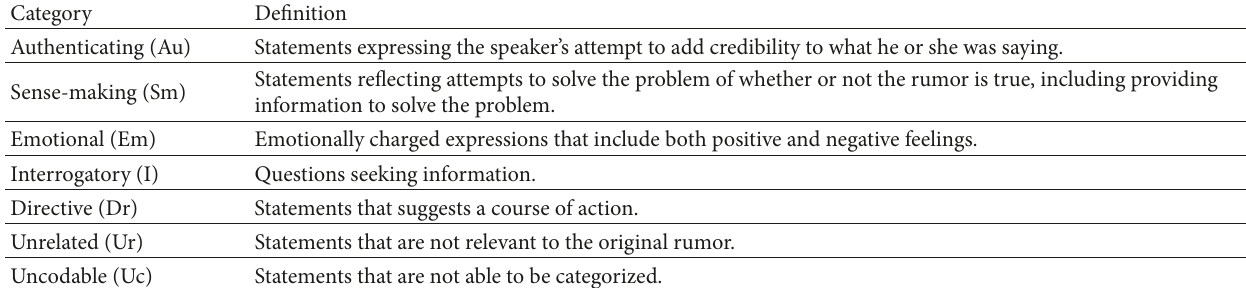
Table 1: Statement coding category and its